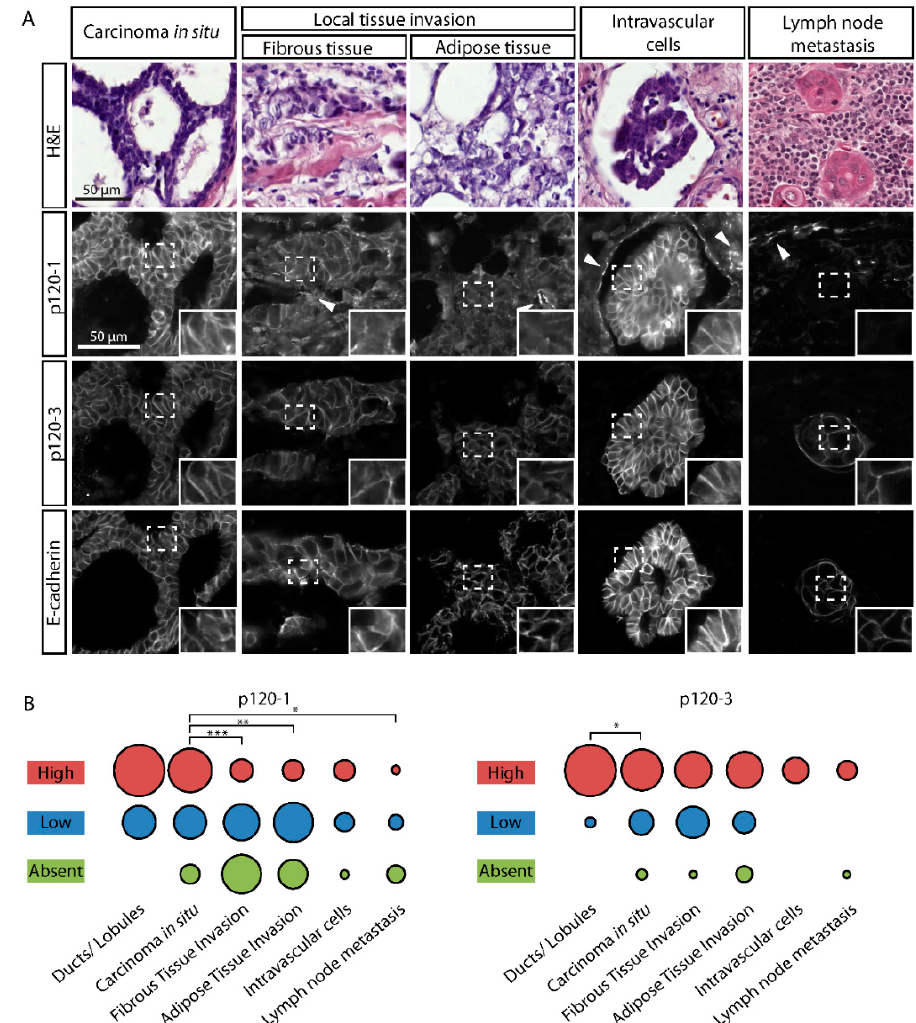
Figure 4. P120 isoform expression in different breast tumor subregions. ( A ) Immunofluorescent labeling of P120 isoforms in breast tumor subregions. Panels show P120-1 (6H11 mAb), P120-3 (anti- P120-3 pAb) and E-cadherin in ductal carcinoma in situ, local invasion into fibrous and adipose tissue, intravascular tumor cells and lymph node metastases. H&E of the subregions from an adjacent section is shown. Intravasated tumor cells or clusters were identified by the surrounding vessel wall from H&E and characteristic endothelial P120-1 expression (arrowheads). ( B ) Quantification of ( A ). * indicates p < 0.05, ** indicates p < 0.01, *** indicates p < 0.001.